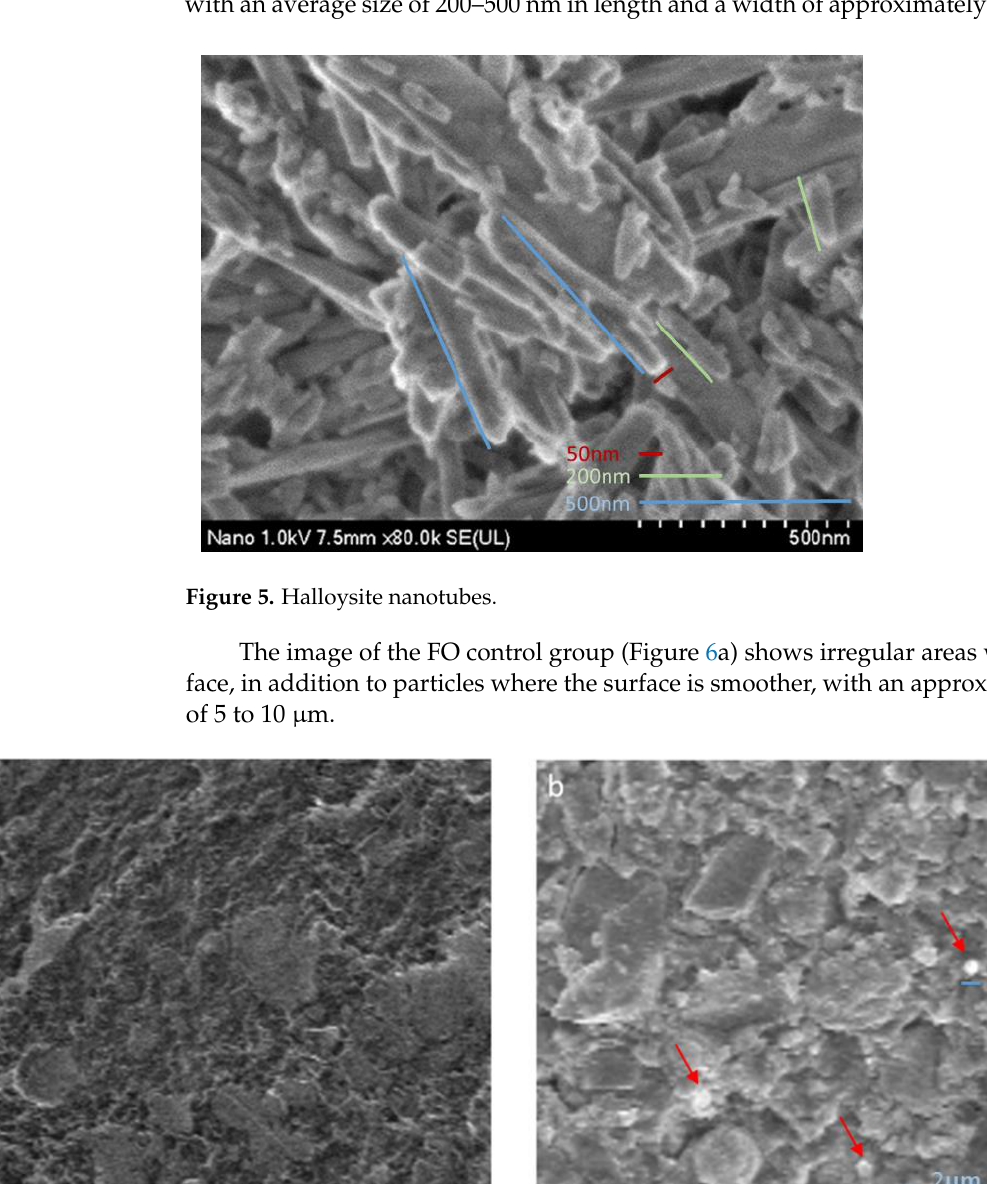
Figure 4. Fuji Ortho sample spectra.